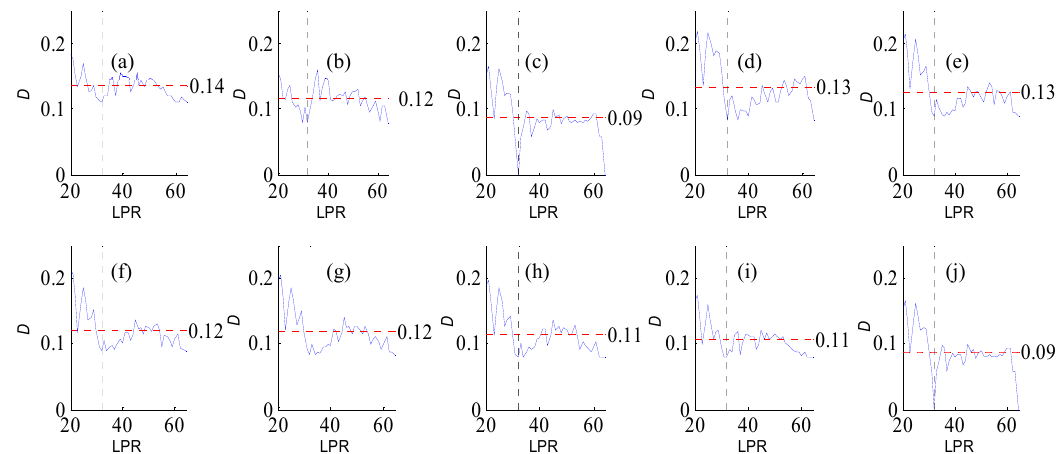
Figure A14. Variation of flow regime alteration degree (D) measured by the RVA with change in the length of post-impact flow time series (LPR) under a periodicity of 31 years. ( a ), ( b ), ( c ), ( d ), ( e ), ( f ), ( g ), ( h ), ( i ), and ( j ) correspond to pre-impact flow time series length = 22, 27, 31, 35, 40, 44, 49, 53, 58, and 62 years, respectively. The abscissa value for the vertical dotted line is 31. The ordinate value for the horizontal dotted line is the mean degree of flow regime alteration in each subfigure.